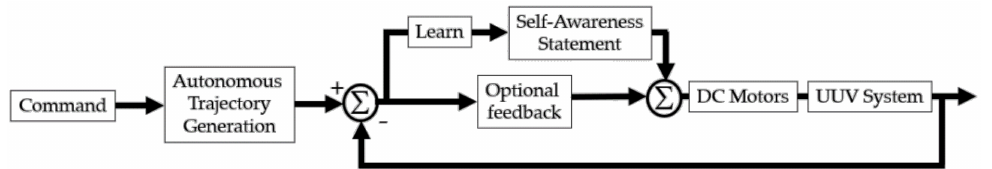
Figure 4. Topology of deterministic artificial intelligence applied to UUV system whose actuators are powered by DC